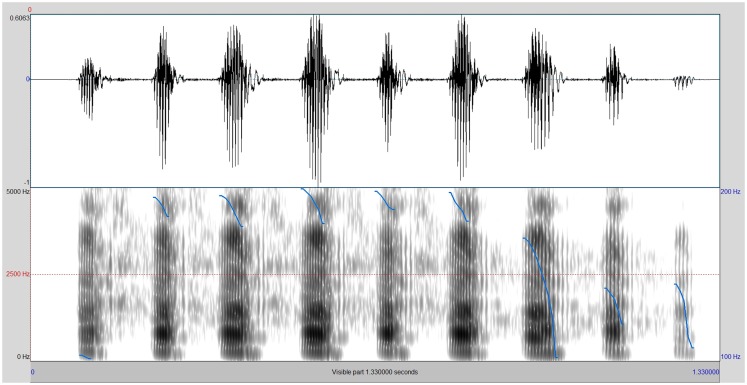
Spectrogram of the vocal laughter stimulus being perceived as most malicious by the gelotophobes.